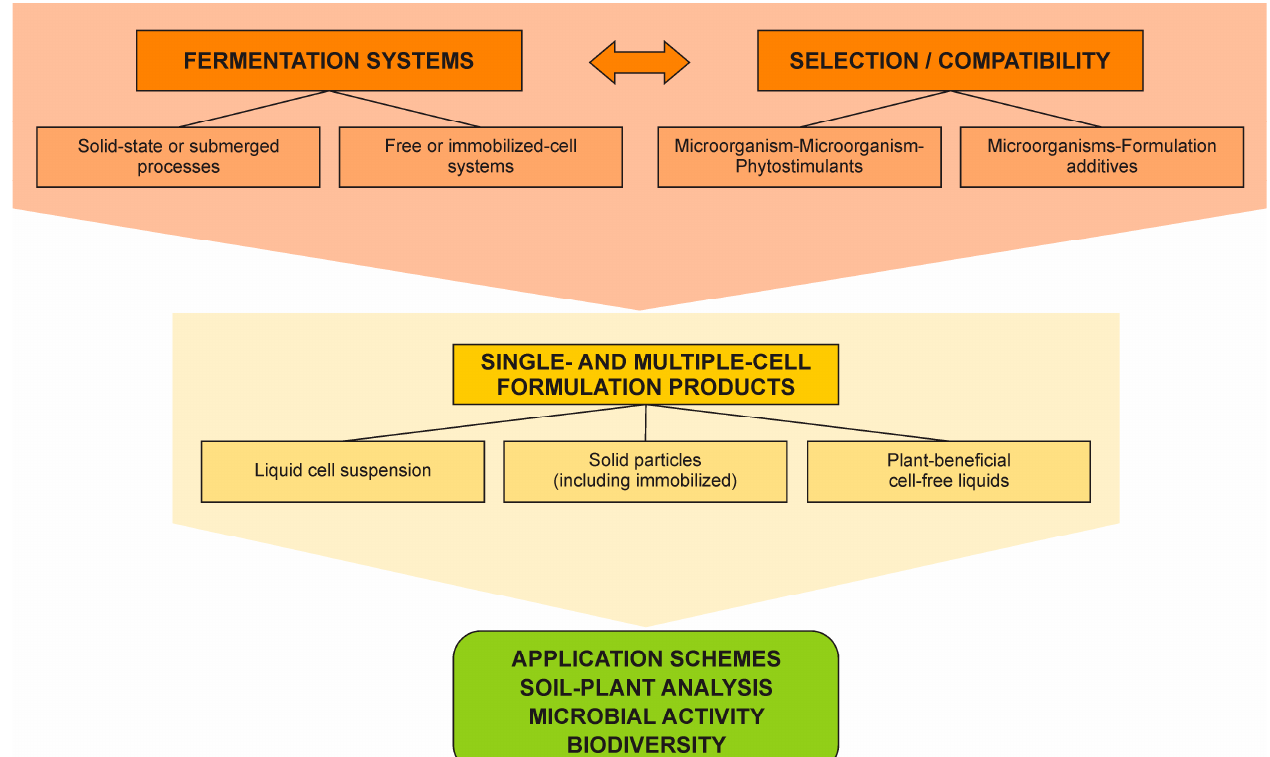
Figure 2. Development of microbial products for plant nutrition. Before reaching field tests, a potential beneficial microorganism must be characterized, efficiently produced, and correctly formulated. The choice of fermentation systems, mixtures of microorganisms and/or phytostimulants and additives, and the formulation will depend on factors such as the microbial species, target plant, mode of action, mode of application, etc. Any wrong decision can compromise the microbial product efficiency.